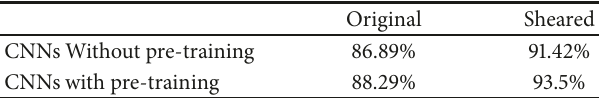
Table 6: The classification accuracy under different